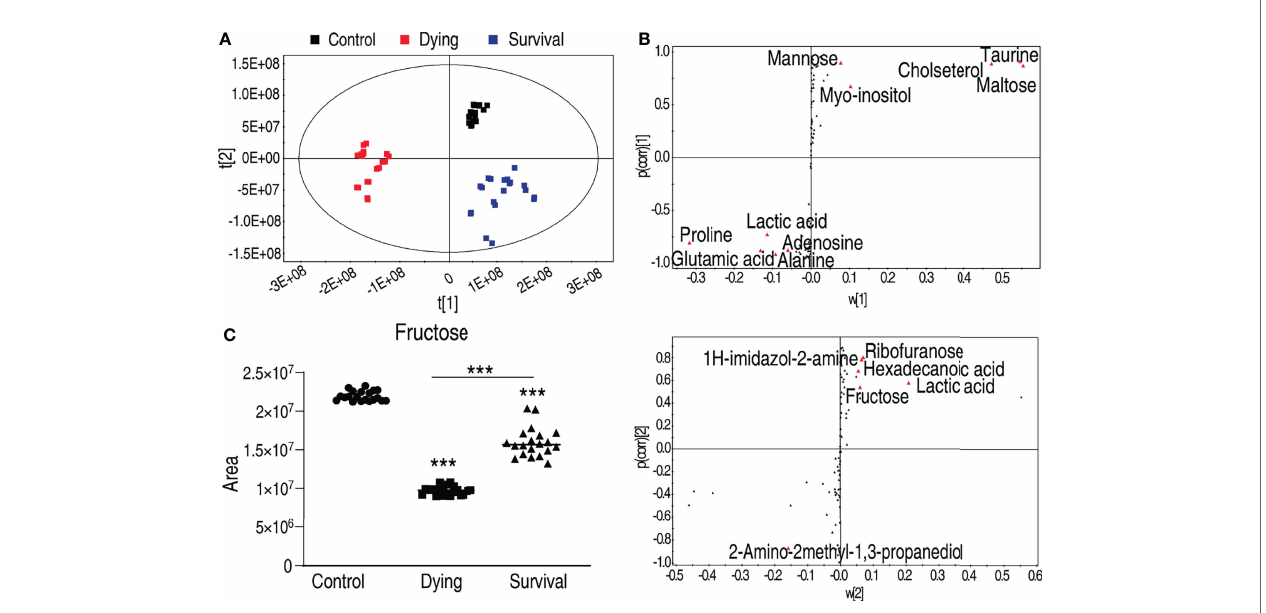
FIGURE 3 | Identi fi cation of crucial metabolites that differs survival group from dying group. (A) The PCA analysis of the metabolomic data. (B) S-plot, generated by PLS-DA, to identify differential metabolites of intragroup as from t[1] and t[2] in (A) . The upper panel corresponds to t[1], and the lower panel corresponds to t[2]. Each triangle represents individual metabolite, where potential biomarkers are highlighted with red, which is greater or equal to 0.05 and 0.5 for the absolute value of covariance p and correlation p (corr), respectively. (C) The abundance of fructose is the control, dying, and survival groups, respectively. ***p <